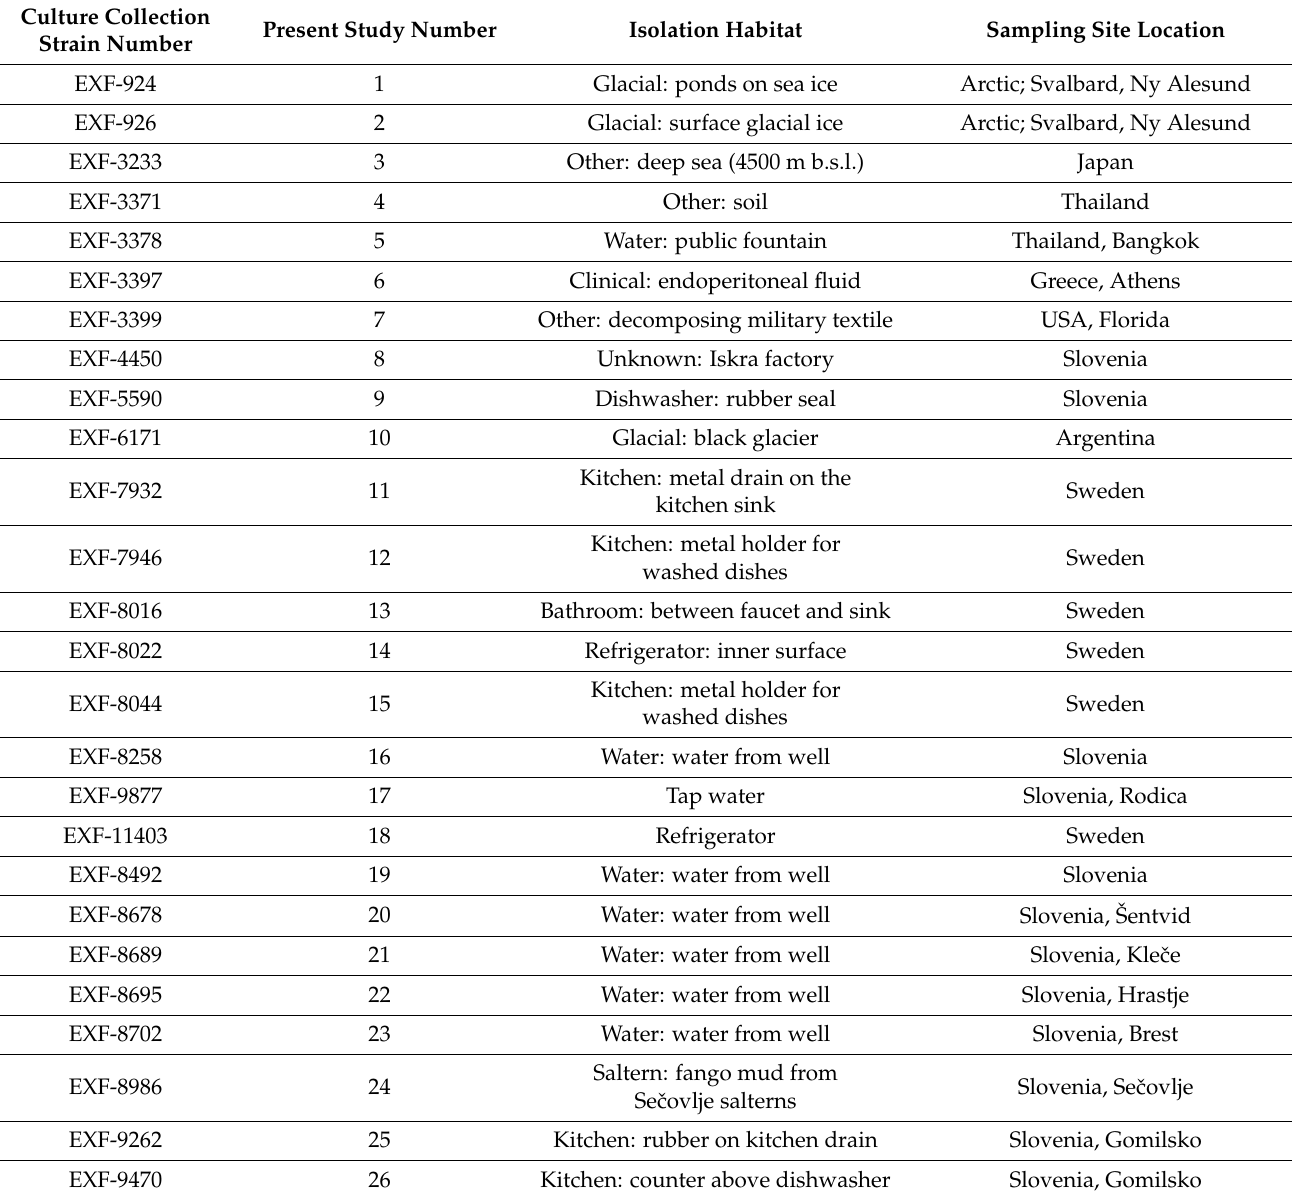
Table 1. List of A. melanogenum strains used in this